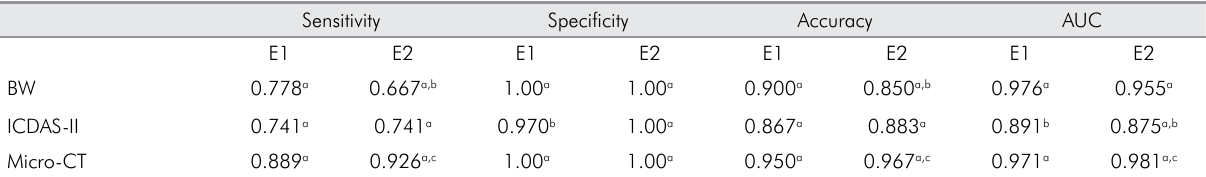
Table 3. Sensitivities, specificities, accuracies, and AUC values for each detection method at threshold D3.